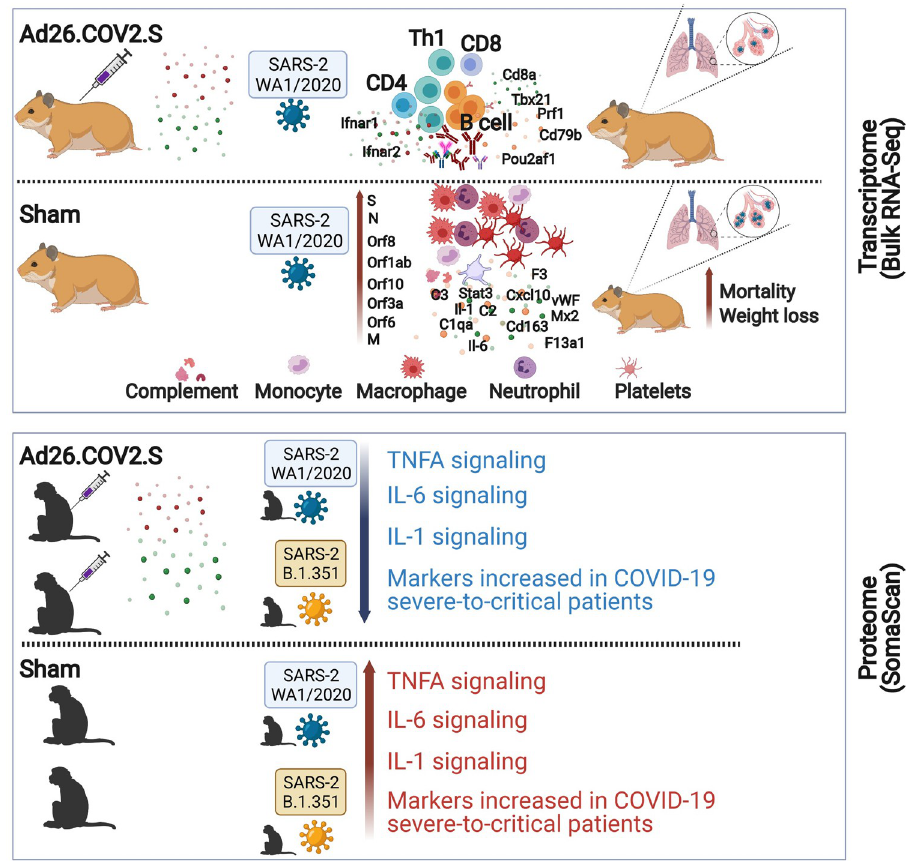
Fig 7. Ad26.COV2.S abrogates proinflammatory and thrombosis associated pathways in hamsters and macaques challenged with SARS-CoV-2 WA and B.1.351. Fig 7 was created with